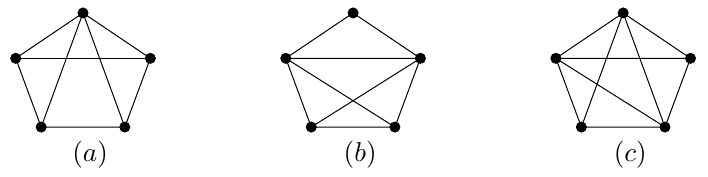
Figure 4 . Some examples of four-point structure counting in intersection graphs with (cid:12)ve